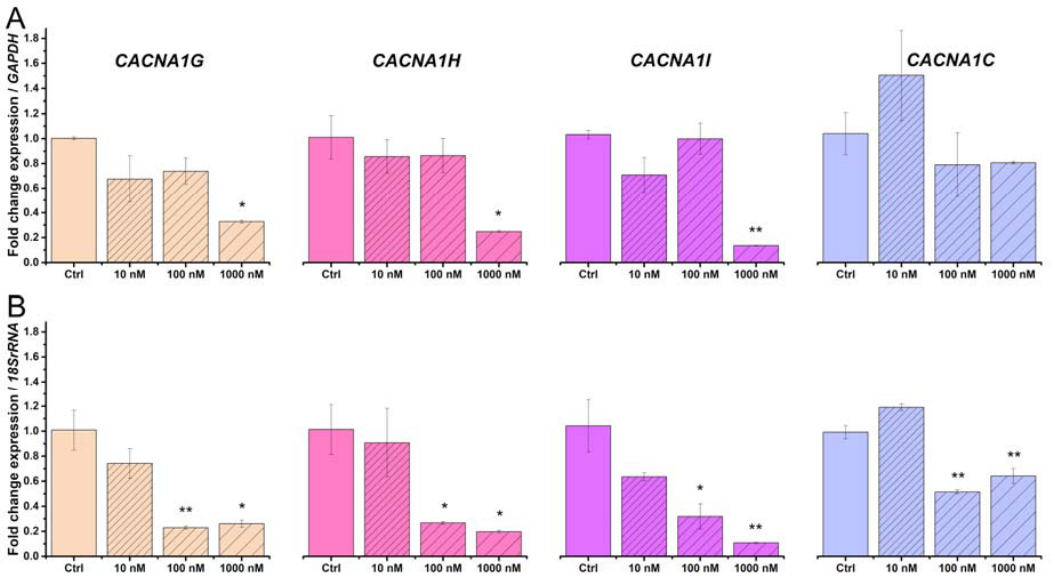
Figure 3. Effect of beta ‐ estradiol treatment (10, 100, and 1000 nM) on the mRNA levels encoding the voltage ‐ gated calcium channels in human myometrial TCs from pregnant uterine samples. Fold ‐ change for each voltage ‐ gated calcium channel upon treatment with beta ‐ estradiol, where the non ‐ treated samples were considered as calibrator. The data were normalized against GAPDH ( A ) and 18S rRNA ( B ) and were plotted as mean ± SD ( N = 3). Statistical significance is indicated with asterisks (* 0.01 < p < 0.05; ** 0.001 < p < 0.01).